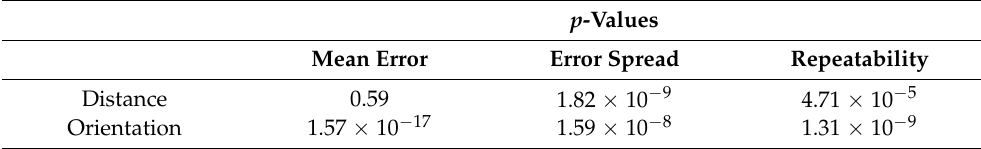
Table 3. Mann-Whitney U -test